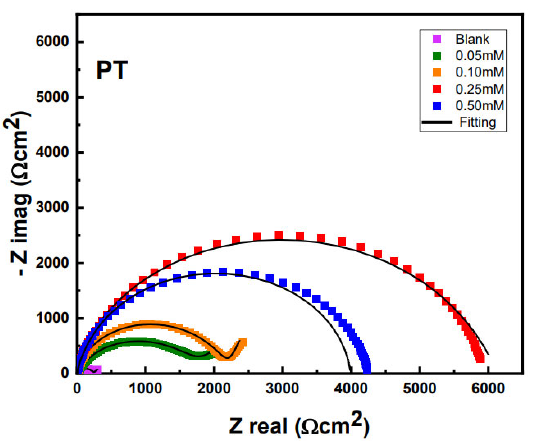
Figure 6. Nyquist plots of brass samples with and without different concentrations of corrosion inhibitors in 0.5 M H 2 SO 4 H SO . 2 4